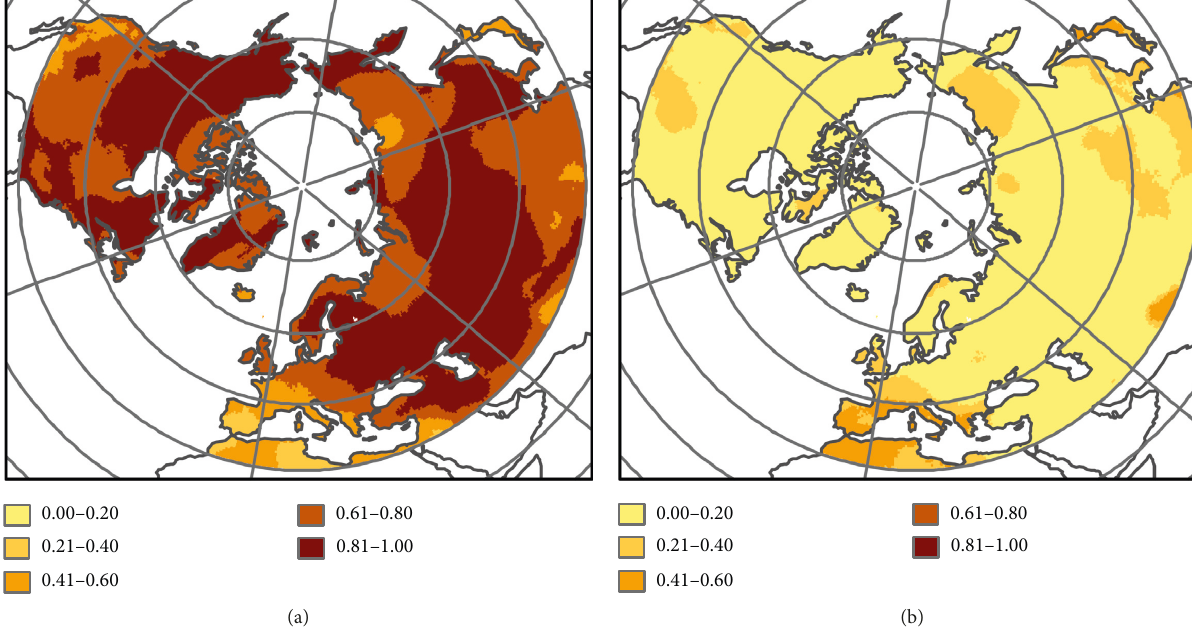
Figure 2: The determination coefficient ( R 2 ) between Conrad’s Continentality Index (CCI) and the average temperature of the (a) coldest ) and (b) warmest ( T ) months in ( T min max